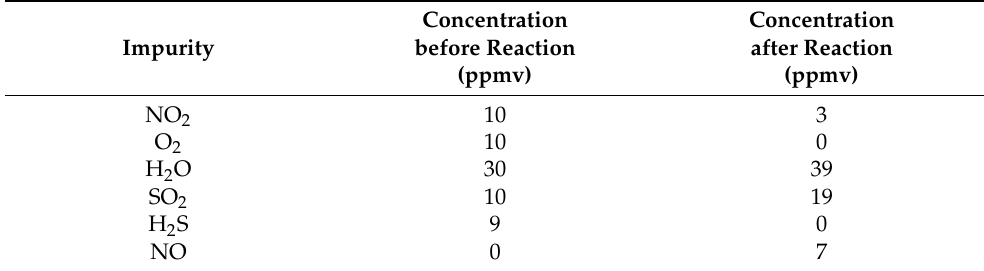
Table 1. Prediction based only on the reactions; the input impurities are the sum of all streams while the output concentration are the results of the